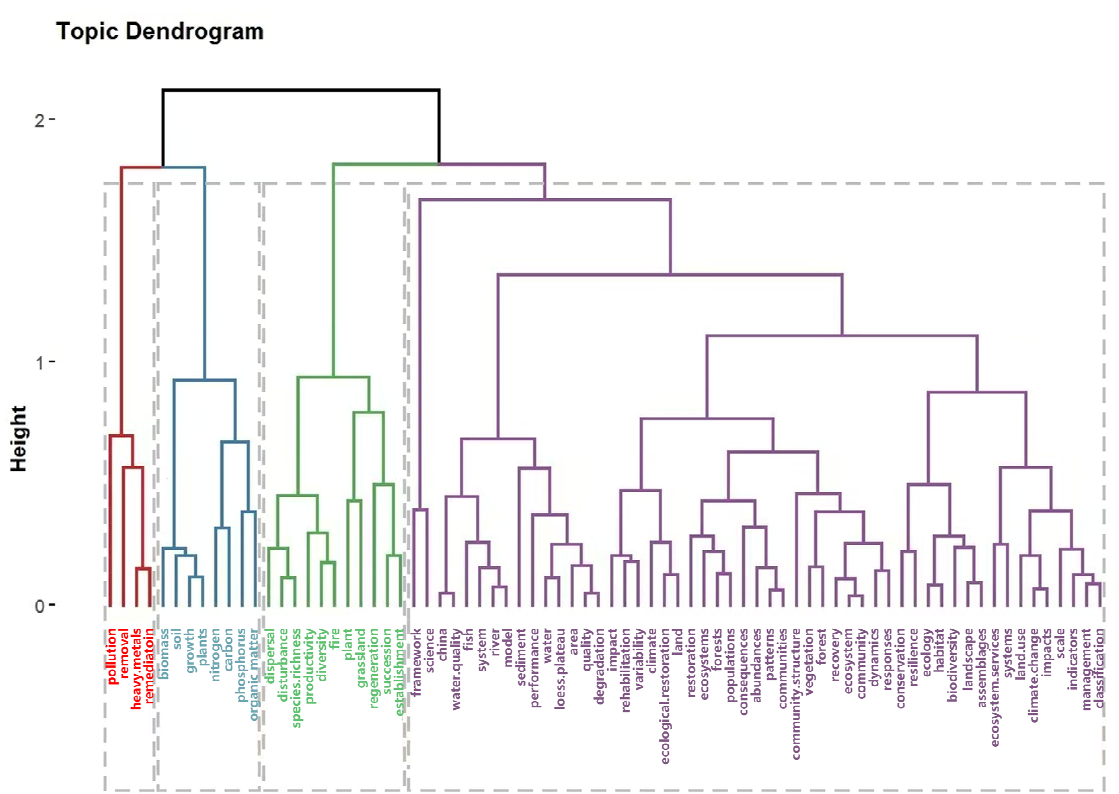
Figure 8. Dendrogram of the system cluster analysis of keywords in the field of ecological restoration from 1990 to 2022.